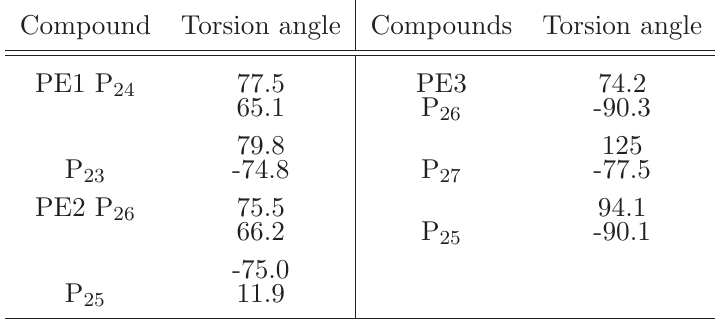
Table 3 Torsion angle between phosphinine units and phenyl substituent obtained from PM3 calculation (deg)